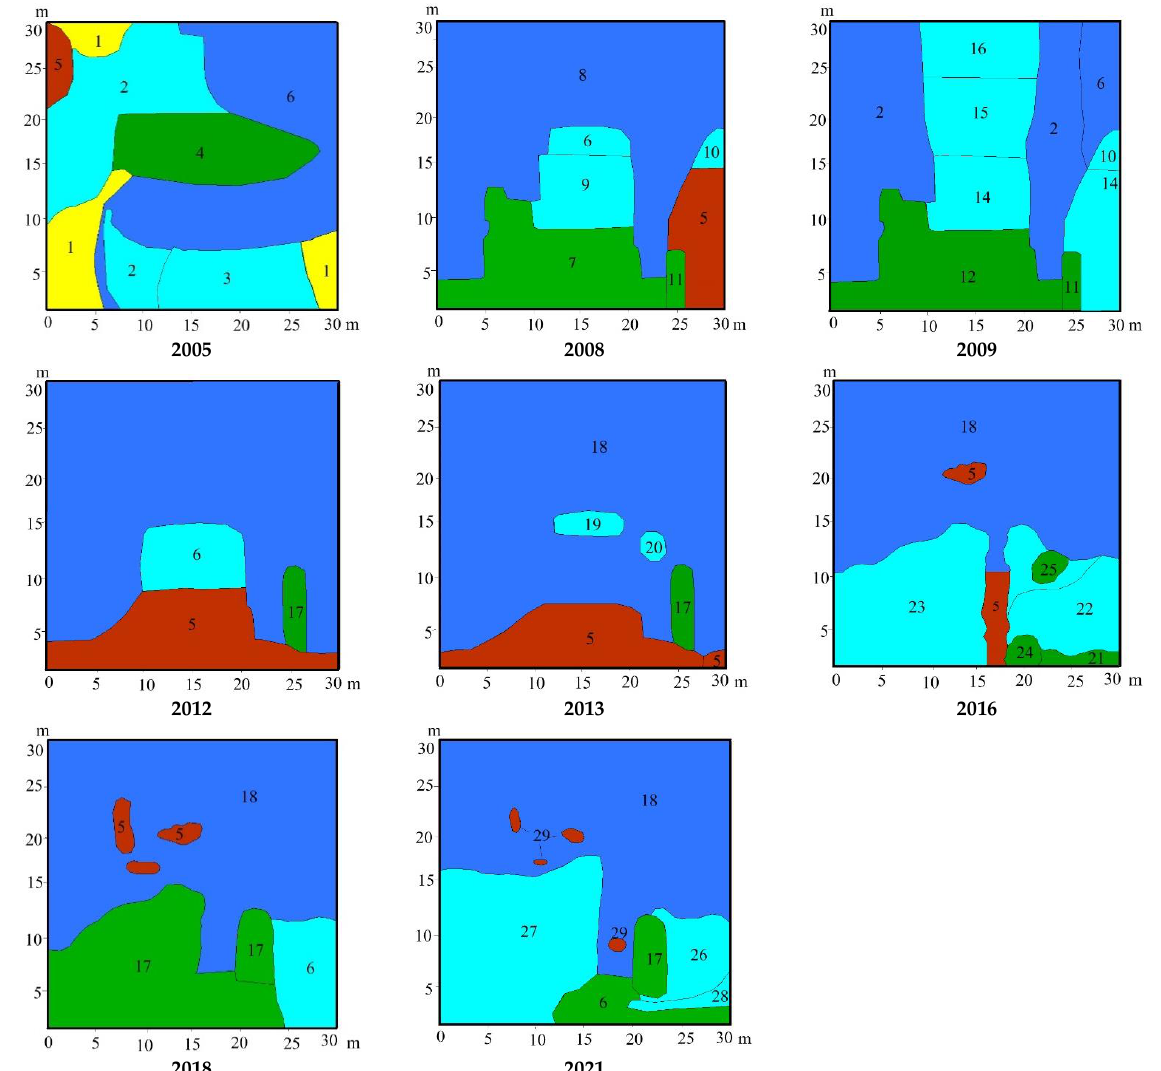
Figure 19. Changes in vegetation on permanent plot No. 9: 1 Calamagrostis epigejos + Persicaria maculosa ; 2 Scirpus sylvaticus + Juncus conglomeratus ; 3 Carex pseudocyperus + S. sylvaticus ; 4 Salix cinerea + Salix myrsinifolia – C. epigejos + Lycopus europaeus ; 5 bare peat; 6 quagmire; 7 Betula pubescens – J. conglomeratus + C. epigejos ; 8 Alisma plantago-aquatica + S. sylvaticus ; 9 C. epigejos + J. conglomeratus ; 10 S. sylvaticus ; 11 B. pubescens – C. epigejos + Agrostis canina ; 12 B. pubescens – C. epigejos + J. conglomer- atus ; 13 A. plantago-aquatica + S. sylvaticus – Sphagnum squarrosum ; 14 C. epigejos + A. canina ; 15 Typha latifolia ; 16 S. sylvaticus – Bidens tripartite ; 17 B. pubescens + S. cinerea ; 18 water; 19 S. cinerea - Phragmites. australis ; 20 Carex rostrata + S. sylvaticus ; 21 B. pubescens – Calamagrostis canescens + Carex canescens ; 22 P. australis + A. plantago-aquatica ; 23 P. australis + Hydrocharis morsus-ranae ; 24. Thickets B. pubescens ; 25 B. pubescens – Polytrichum juniperinum ; 26. A. plantago – aquatica ; 27 P. australis ; 28 B. pubescens – S. cinerea ; 29 single C. pseudocyperus